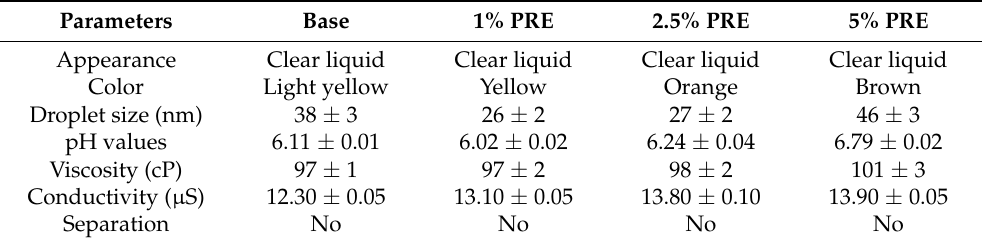
Table 5. Physical properties of the microemulsion base and microemulsions containing PRE at various